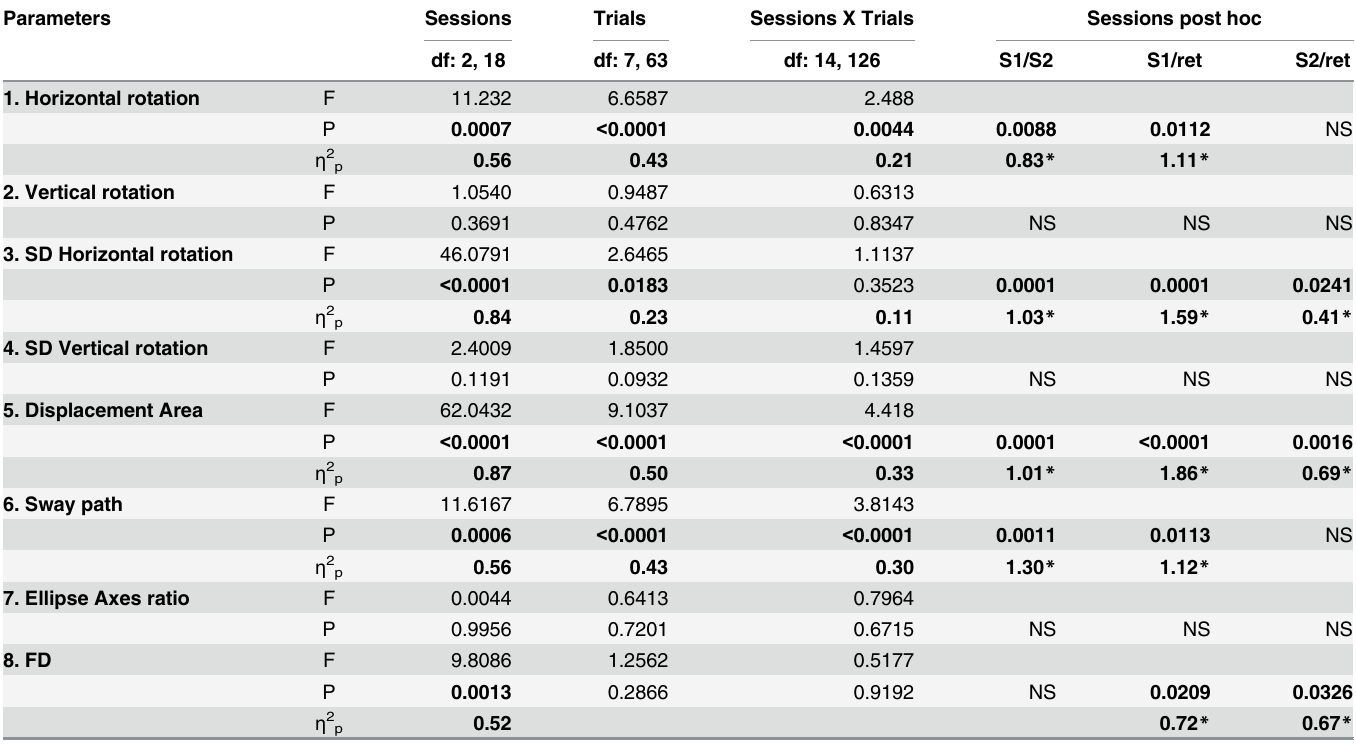
Table 1. Summary of statistical analysis for any direction board motion.